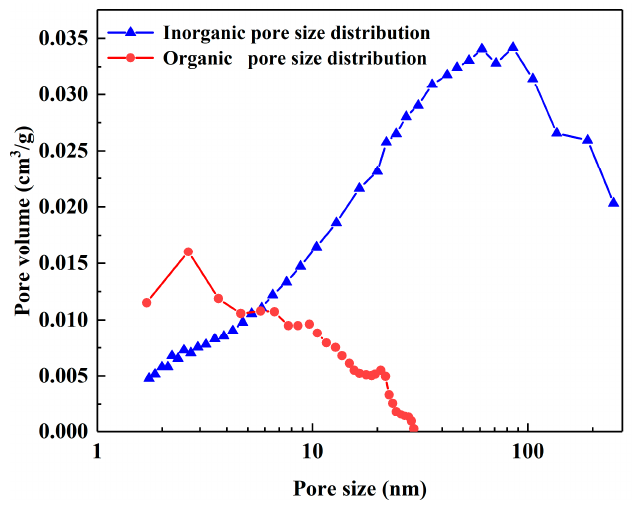
Figure 14. The pore size distribution in shale matrix.